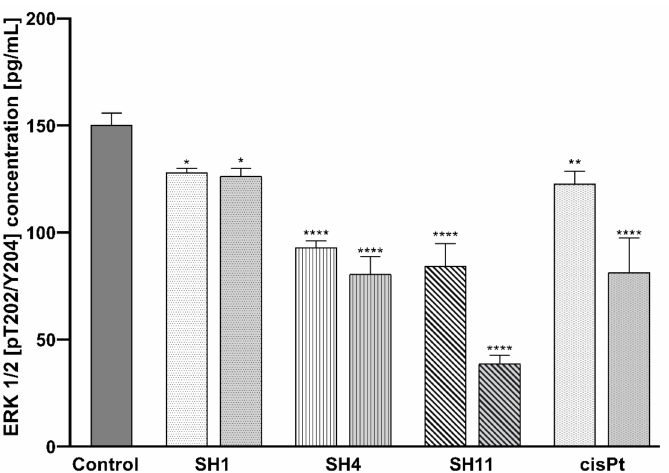
Figure 7. Concentrations of ERK 1/2 [pT202/Y204] in MCF-7 cells after 24-h incubation with SH1 , SH4 , SH11 , and cisPt. The tested concentrations were 600 µ g/mL and 800 µ g/mL for SH1 and SH4 , 200 µ g/mL and 400 µ g/mL for SH11 , and 50 µ M and 100 µ M for cisPt. Results are presented as mean ± SD from three independent experiments performed in duplicate. Statistical significance was calculated using one-way ANOVA with Bonferroni multiple comparison test. Differences were considered statistically significant at * ( p ≤ 0.05), ** ( p ≤ 0.005), and **** ( p ≤